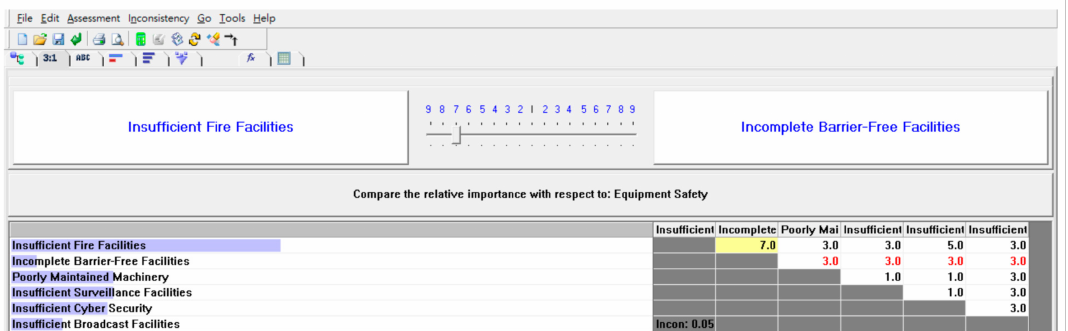
Figure 6. Expert Choice 11.0 numerical input